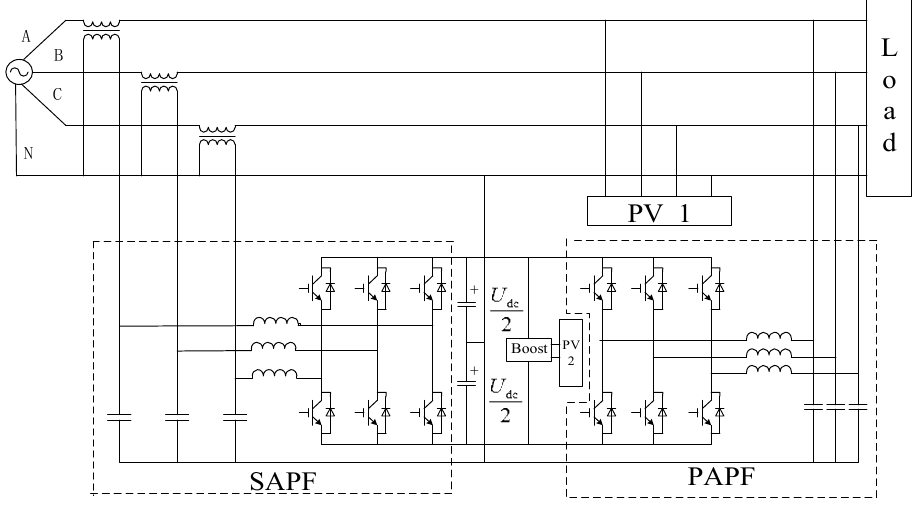
Figure 1. The topology of the UPQC in the PV micro-grid.